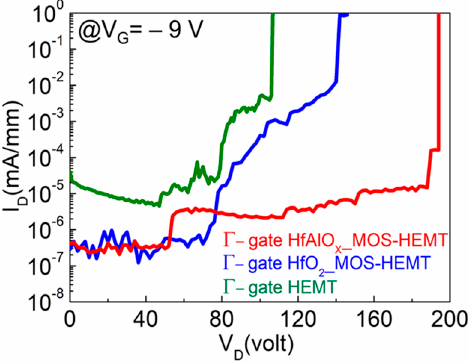
Figure 7. Comparison of breakdown voltage characteristics of Γ -gate HEMT , HfO 2 , and HfAlO X MOS-HEMT with the N 2 plasma treatment.